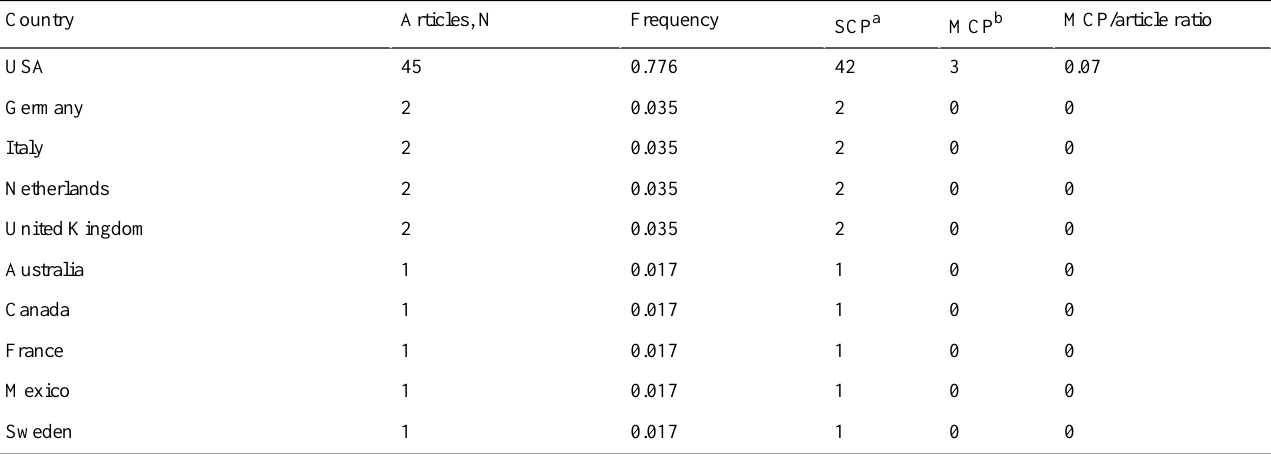
Table 3. Most relevant countries by corresponding